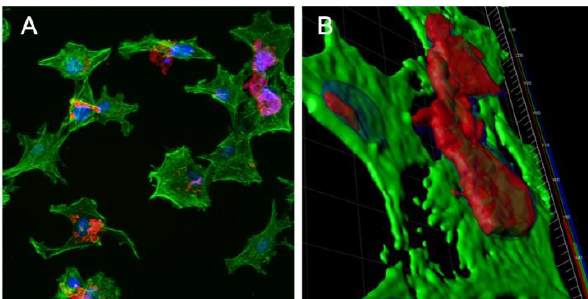
Figure 8. Confocal microscopy images of IMAC cells treated with 100 μg/mL Nile red-labeled PBSe-GSK3787 particles (PBSe-GSK3787-NR) particles (red) for 48 h, then stained with AlexaFluor 488 Phalloidin (green, cytoskeletons) and 4’,6-diamino-2-phenylindole (DAPI) (blue, nuclei): ( A ) 2D image showing agglomerates of particles on the cells; ( B ) 3D rendering of cells showing particles localized at the cell surface and not taken up by the cells.